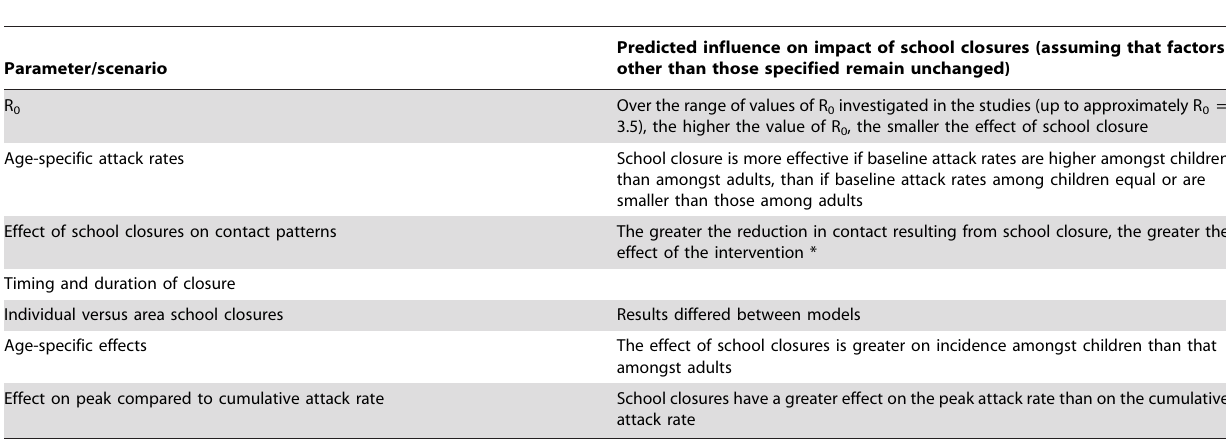
Table 1. Summary of the key findings of factors influencing the impact of school closures, as reflected by the predicted reduction in the peak incidence and the cumulative attack